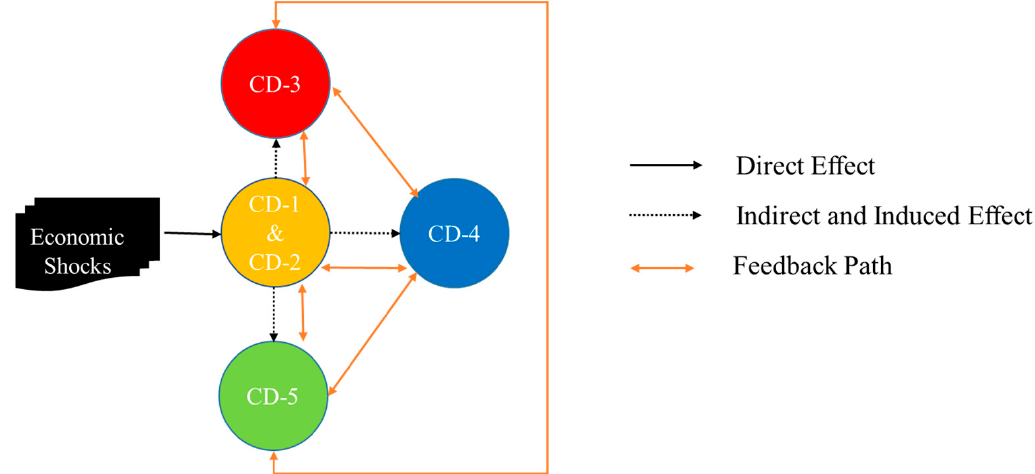
Figure 3. Flows of direct, indirect, induced, and feedback effects.